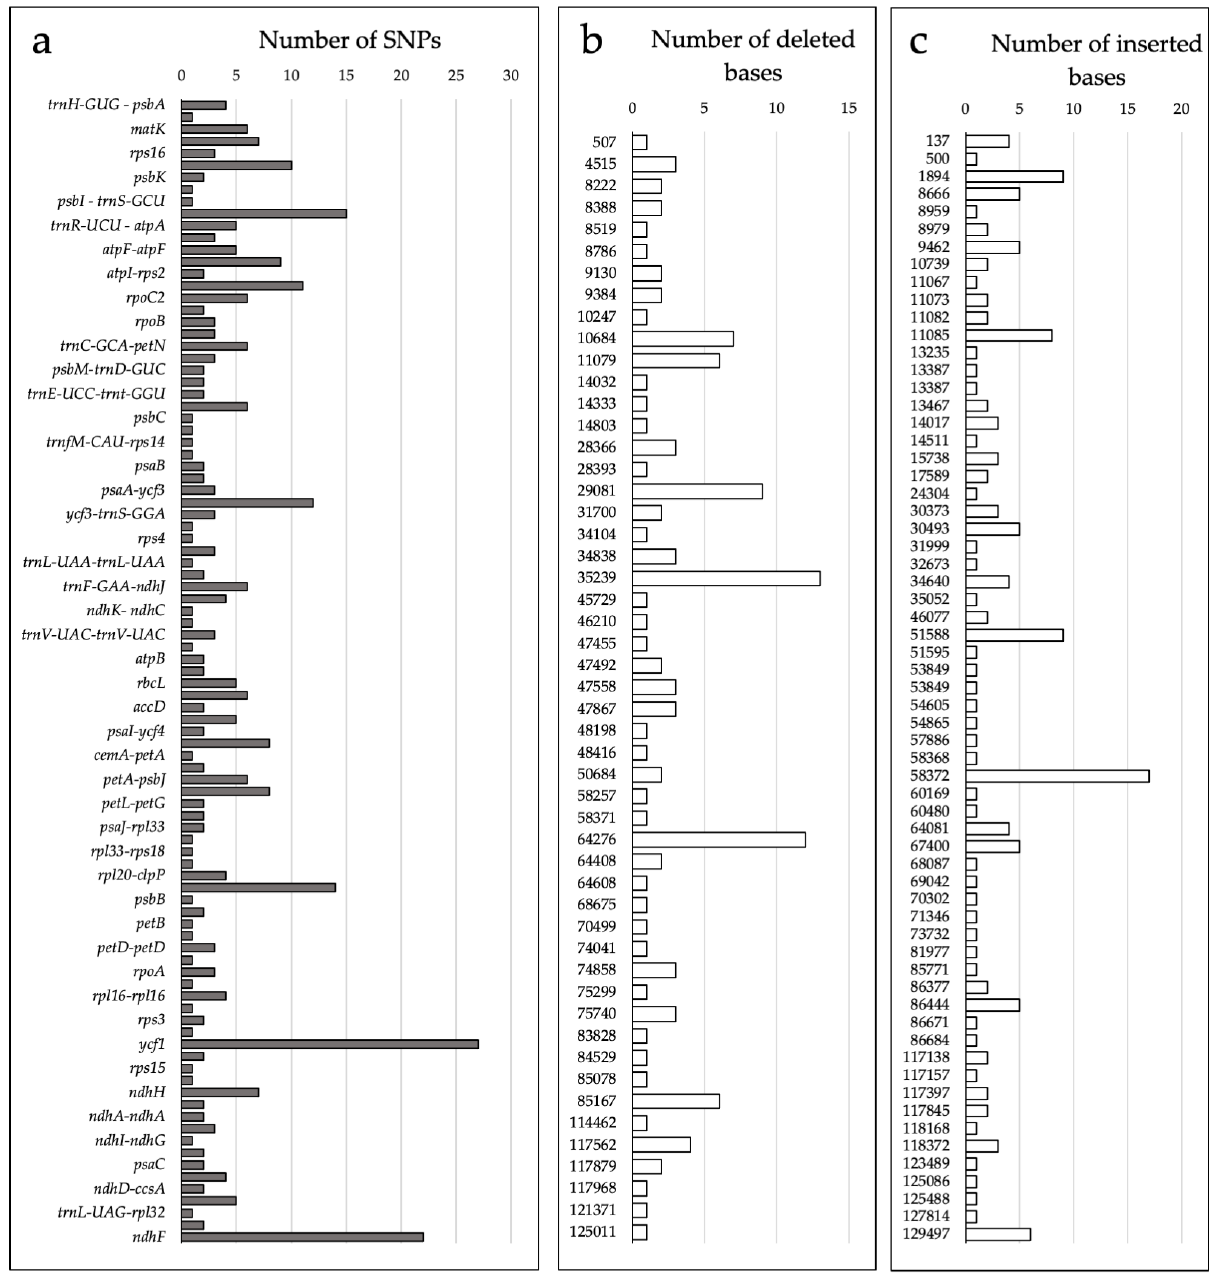
Figure 2 – Distribution of SNPs and indels prospected in the comparison between the plastid genomes of P. phitrantha and P. cauliflora . (a) Number of SNPs in different regions of the plastid genomes. (b) Number of deleted bases in the plastid genome of P. phitrantha in comparison to P. cauliflora . (c) Number of inserted bases in the plastid genome of P. phitrantha in comparison to P. cauliflora . The numbers in the y-axis of b and c correspond to the genomic position, starting from the IRa region in an anti-clock